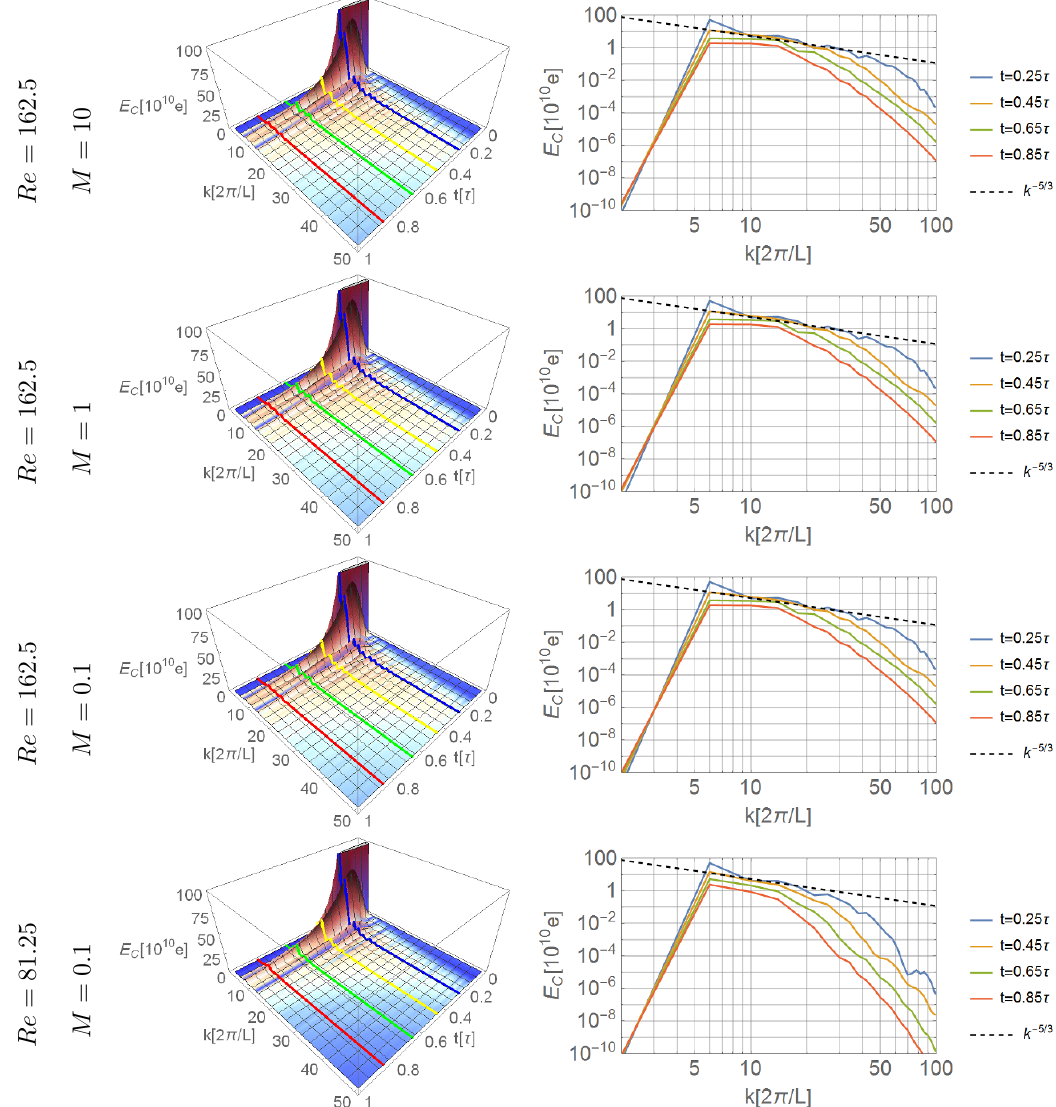
Figure 16 . On the left, the energy spectrum of three dimensional (cid:13)ows with initial mode n = 4 at intermediate times. On the right, log-log plots of selected times of same (cid:13)ows shown in color on the full temporal spectrum (on the left), showing the (cid:12)tting scaling law for each set of parameters. The results on the right are averaged in jumps of four k points, since the initial mode n = 4 sets the jump scale. One can see the Mach number has little to no e(cid:11)ect on the spectrum. All the plots display a weak signature of the expected power law E C ( t; k ) (cid:24) k (cid:0) 5 = 3 . The lowering of the Reynolds number has a signi(cid:12)cant e(cid:11)ect on the power law scaling range, shortening it from k 2 (10 ; 30) when Re = 162 : 5 to k 2 (10 ; 18) when Re = 81 : 25.